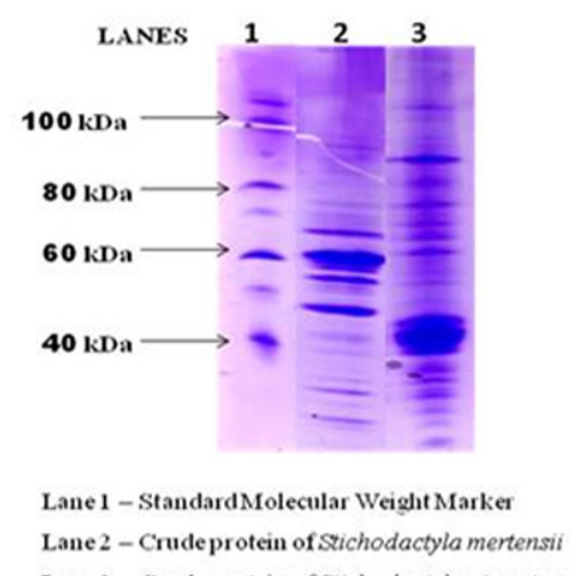
Figure 1. SDS-PAGE analysis of crude venom from S. gigantea and S. mertensii